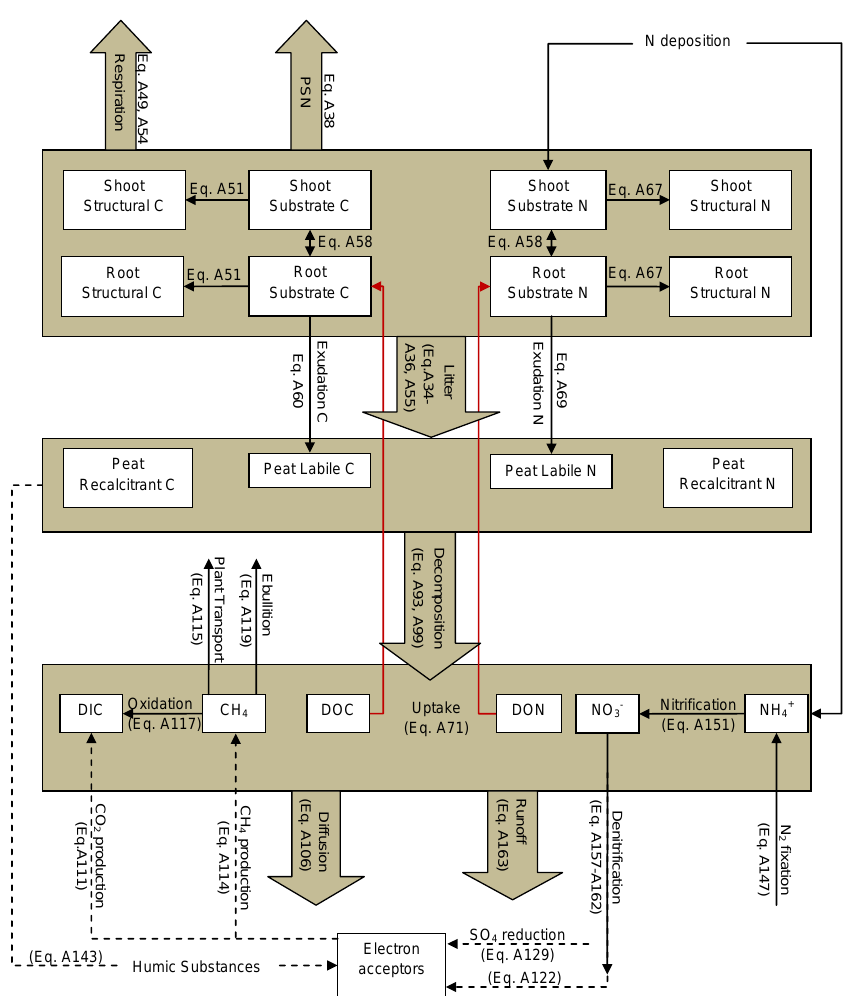
Fig. 2. Schematic C N pools and flows. The black lines are material flows and the dotted lines are information flows. Equations are equations as listed in Appendix